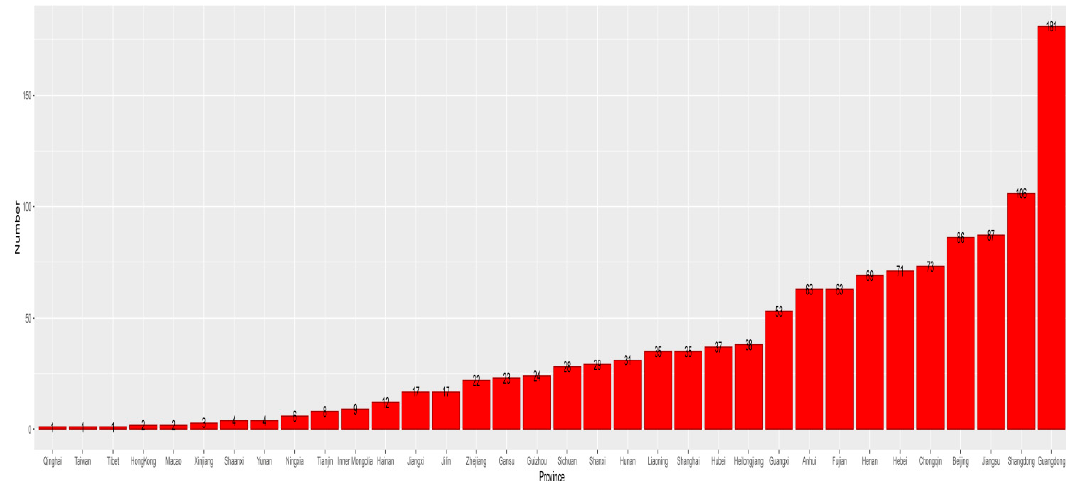
Figure 3. Participants’ provinces of residence.